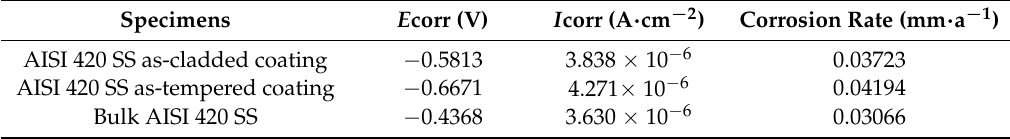
Table 3. Electrochemical parameters of the pre- and post-tempered